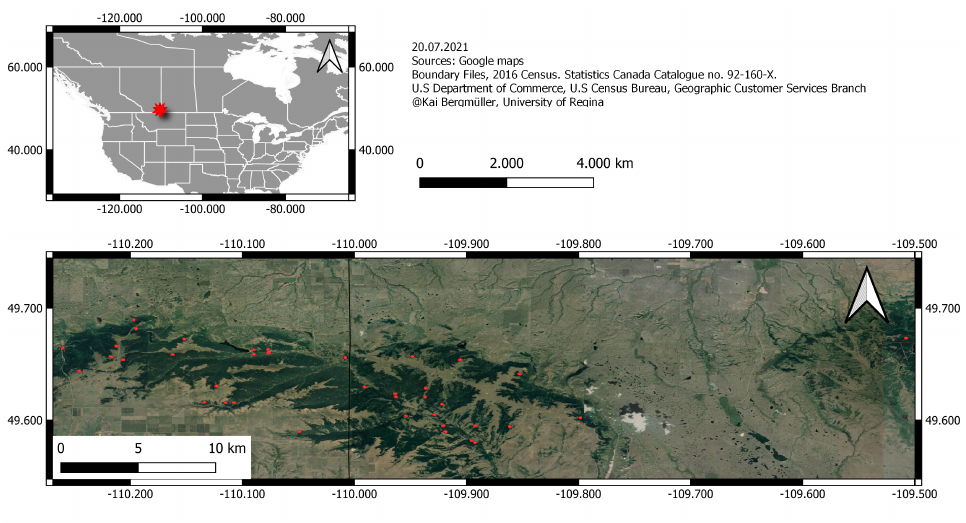
Figure 1. Location of 38 forest stands within Cypress Hill Interprovincial Park. The black line in the middle of the topographic map represents the border between the Canadian provinces of Alberta and